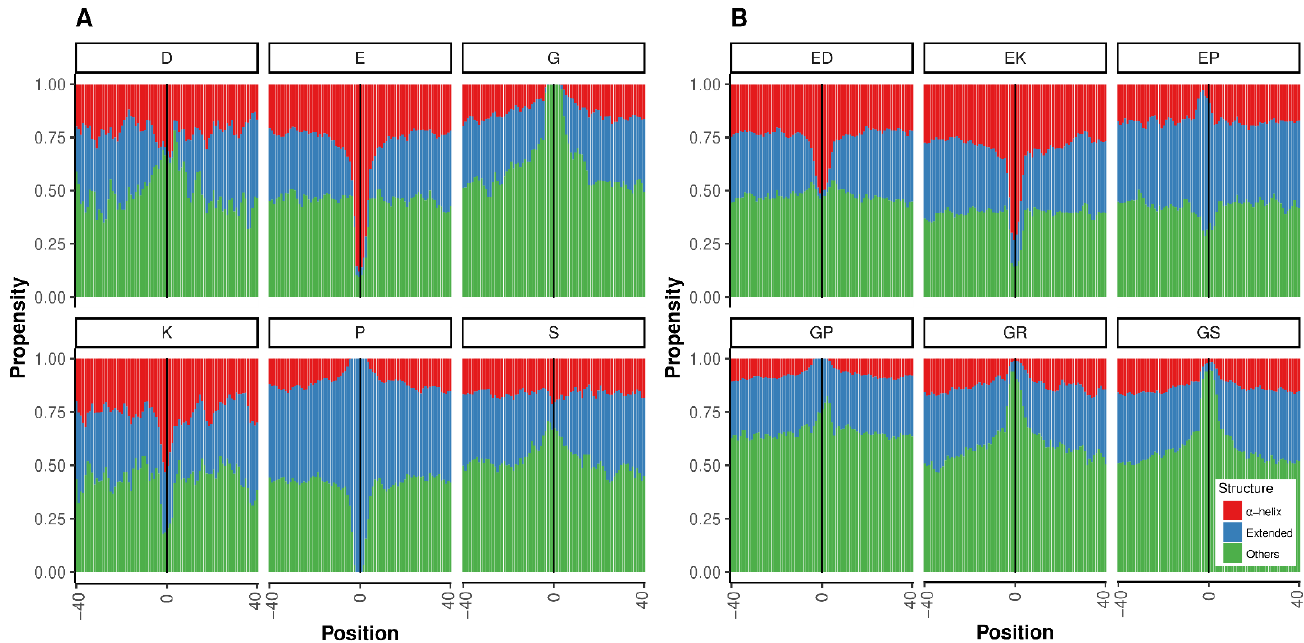
Figure 8. Structural propensities for simple LCRs in IDRs . The structural propensities of LCRs and surrounding regions were computed using LS2P (see the Materials and Methods for details). The vertical line indicates the central position of the LCR. ( A ) The top six more common polyX. ( B ) The top six more common polyXY. Structure types shown are helical (red), extended (blue) and others (green).